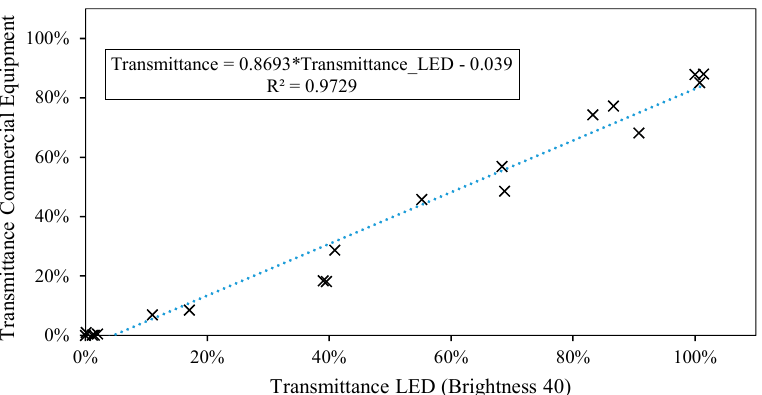
Figure 13. Scatter diagram between transmittance reference value at 450 nm and the most suitable brightness level (T40).